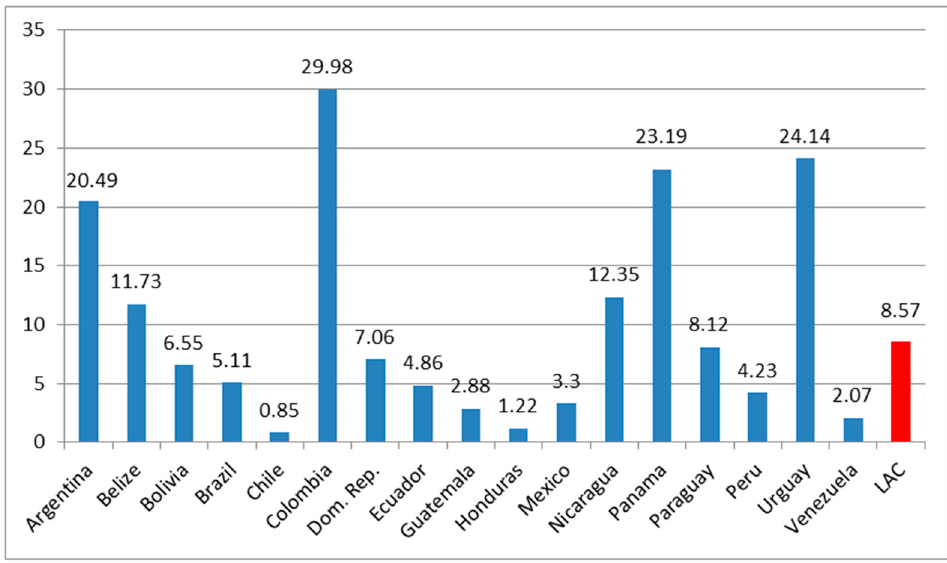
Figure 3. Number of waste pickers per 10,000 inhabitants in LAC [19].